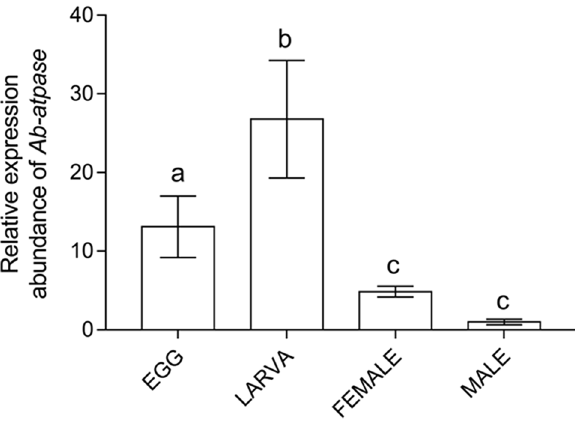
Figure 4. Expression of Ab-atps in Aphelenchoides besseyi of different developmental stages: egg, juvenile, female, and male. Bars indicate standard errors of mean data (n = 3) and letters indicate significant differences ( p < 0.05) between treatments.